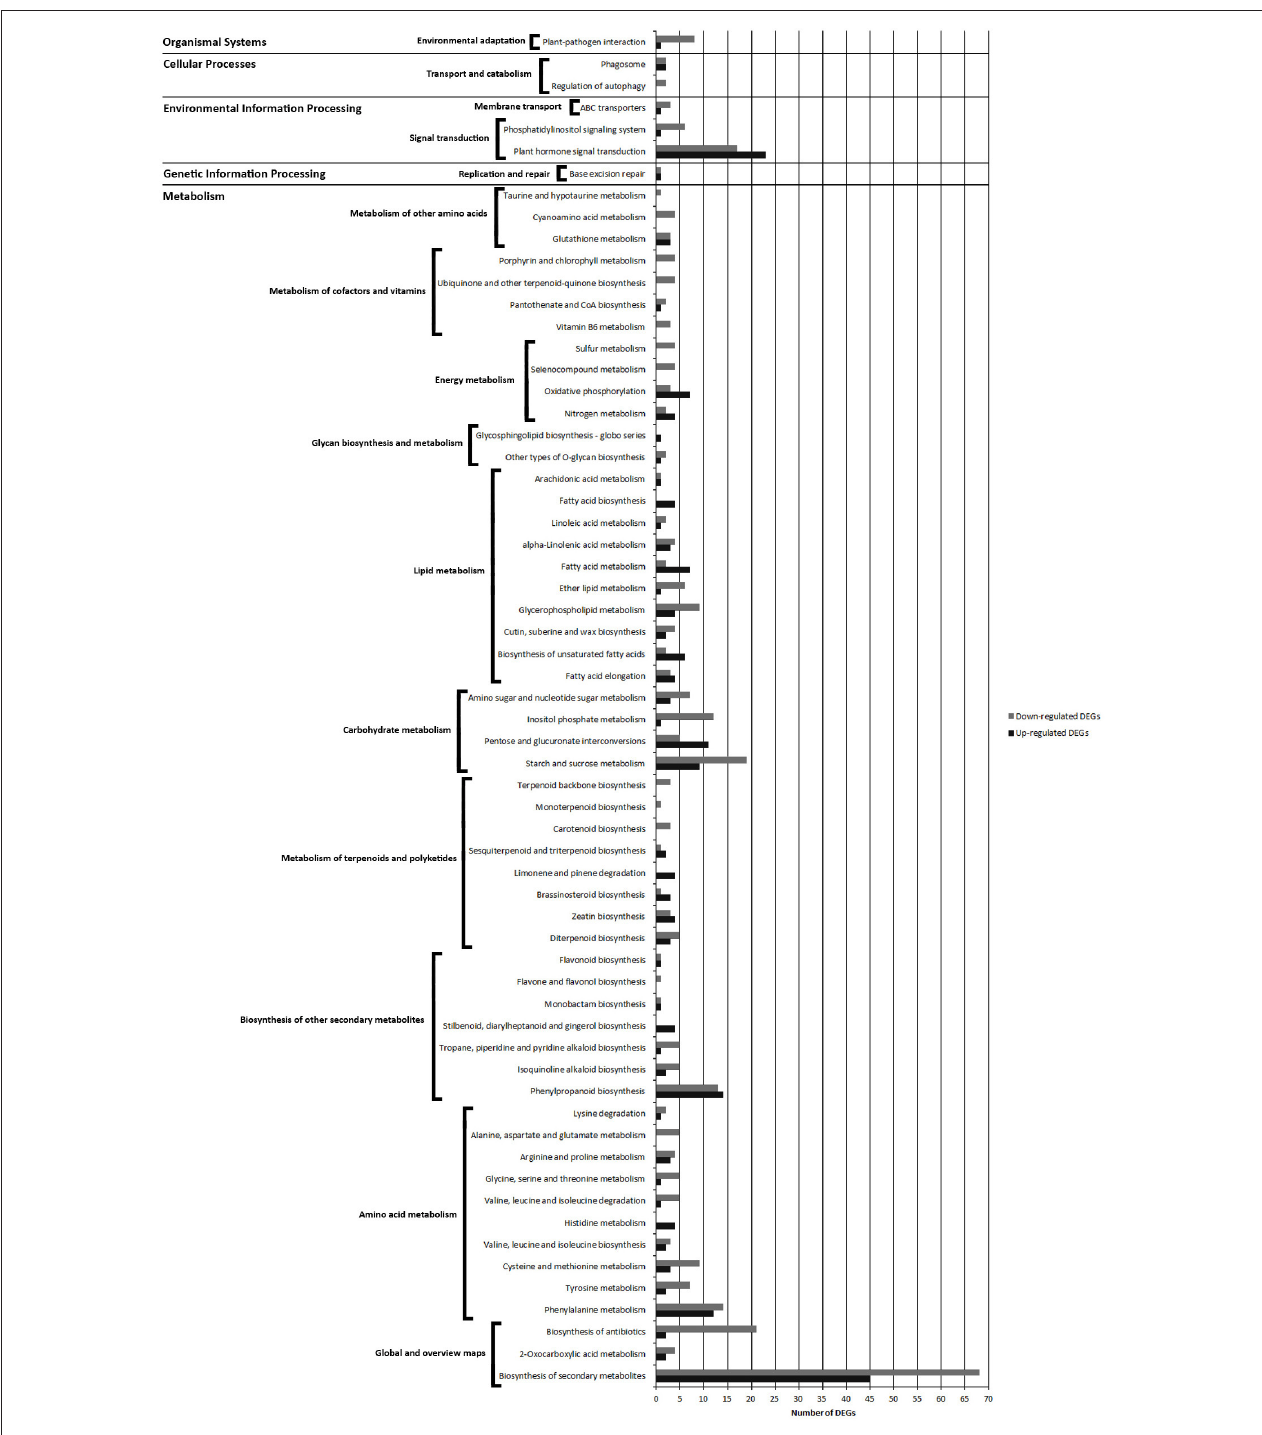
FIGURE 7 | Comparison of the number of up- and down-regulated DEGs identified in FPAB vs. FPNAB library comparison in the KEGG pathways.